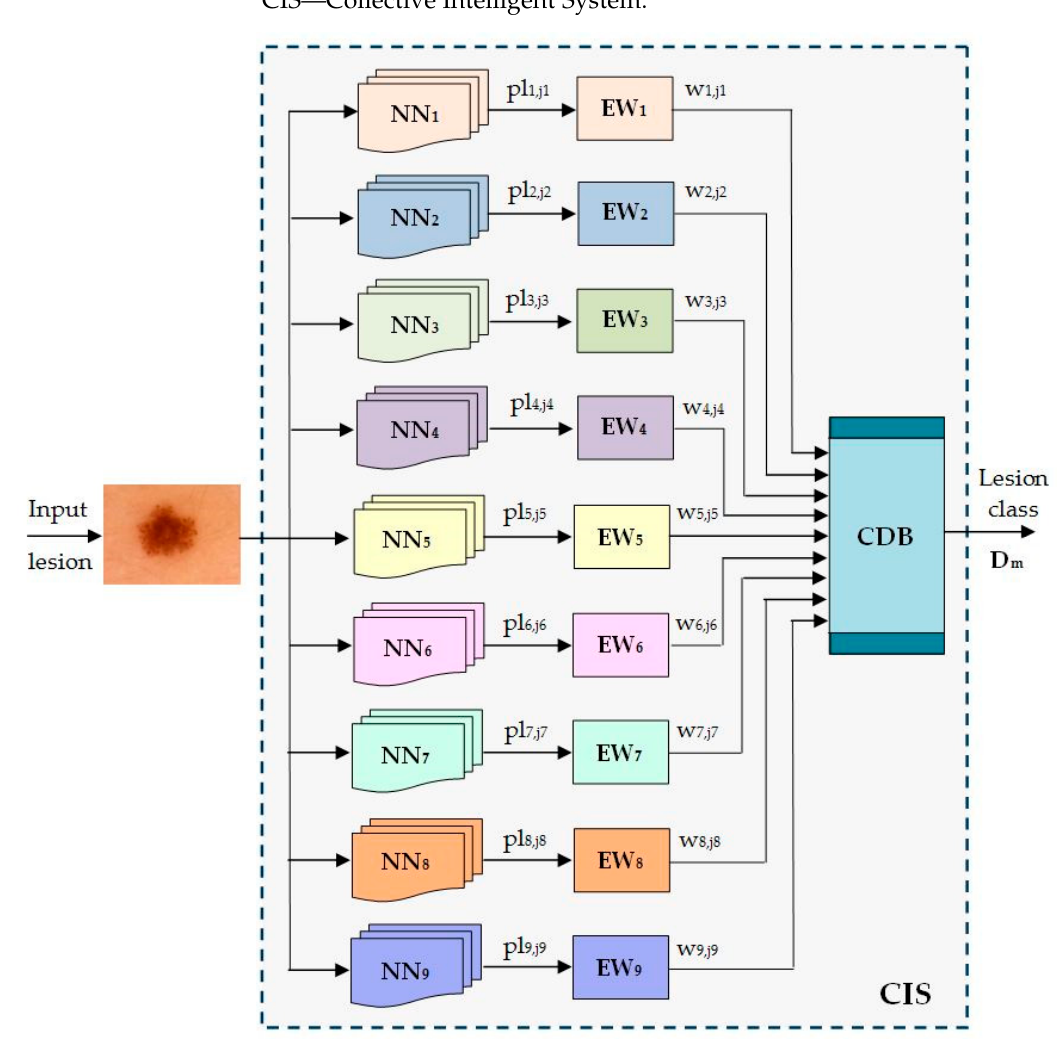
Figure 7. Proposed ensemble model for skin lesion diagnosis.